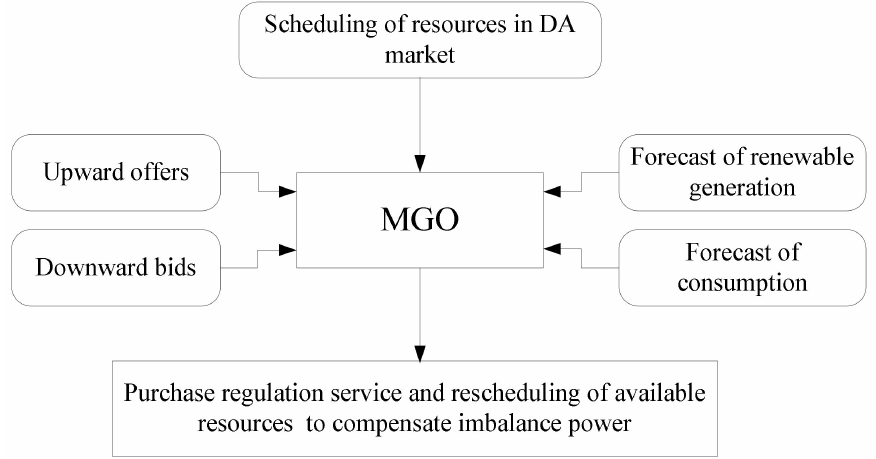
Figure 1. Providing the balancing service by